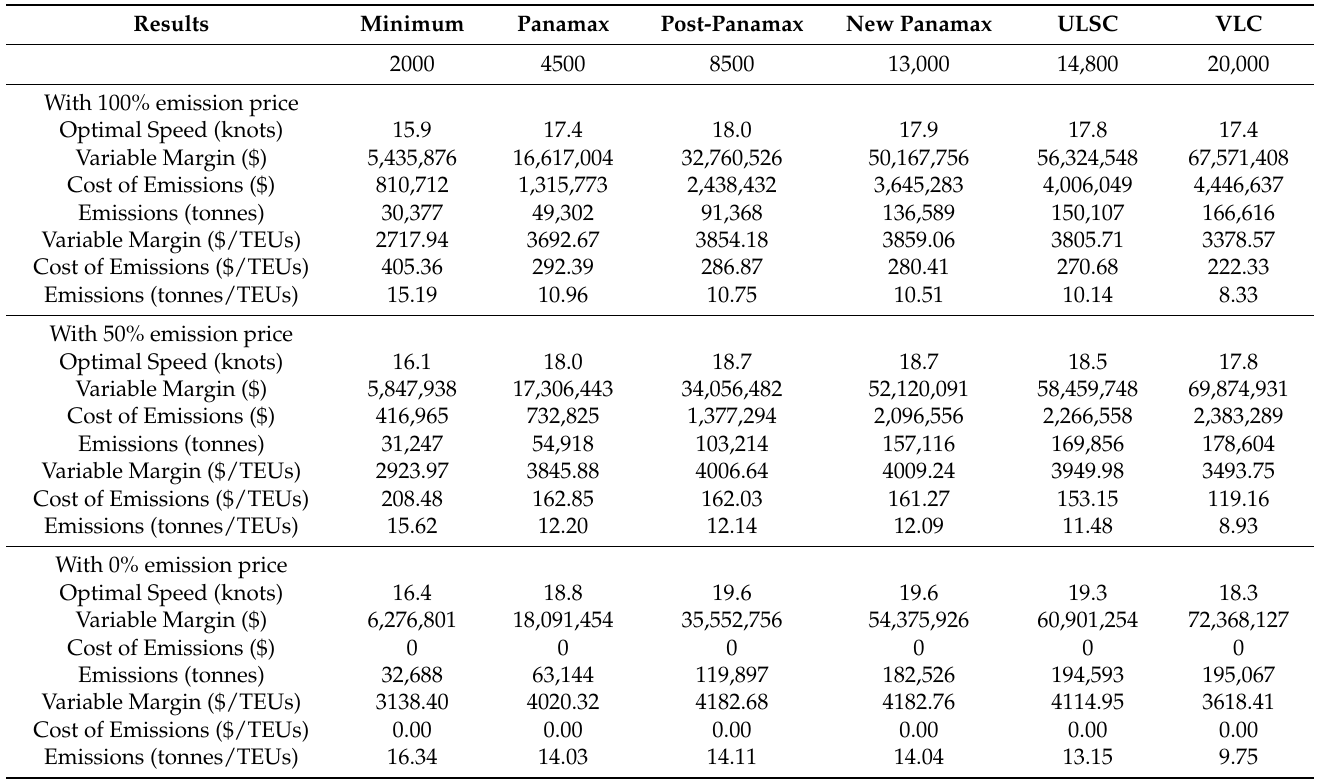
Table 7. Optimal behaviour for selected